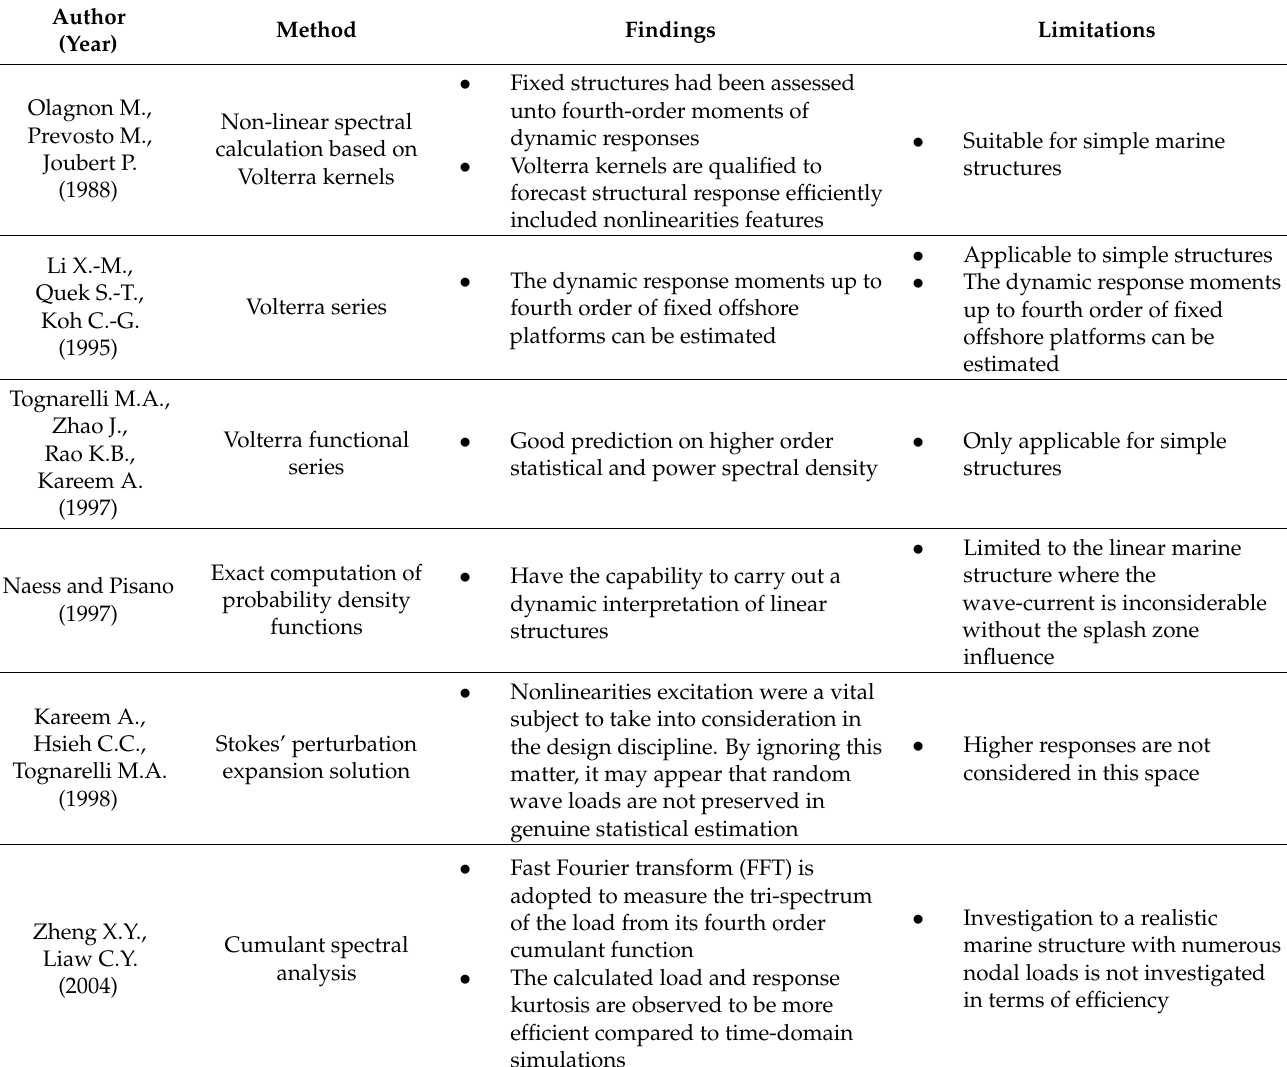
Table 2. Frequency domain method in evaluating extreme